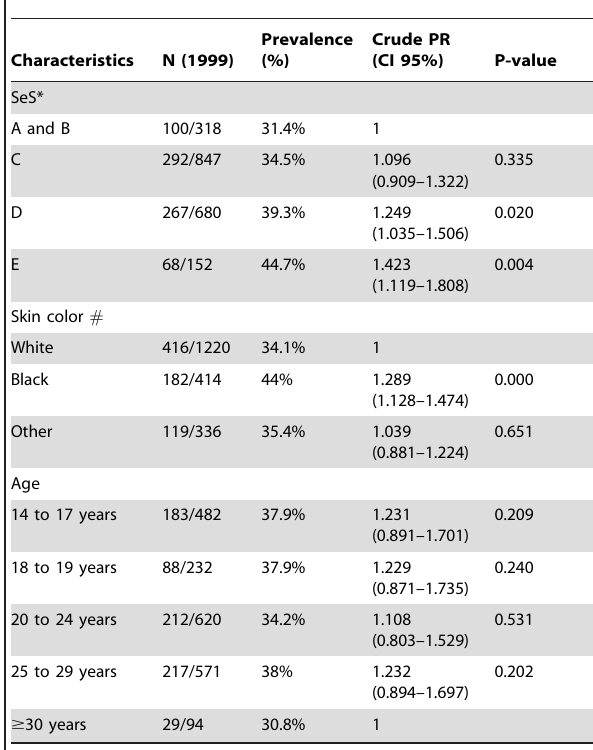
Table 2. Univariate analysis of the predicting factors for anemia in women and crude PR of anemia according to age, social class and skin color in RS, Southern Brazil,